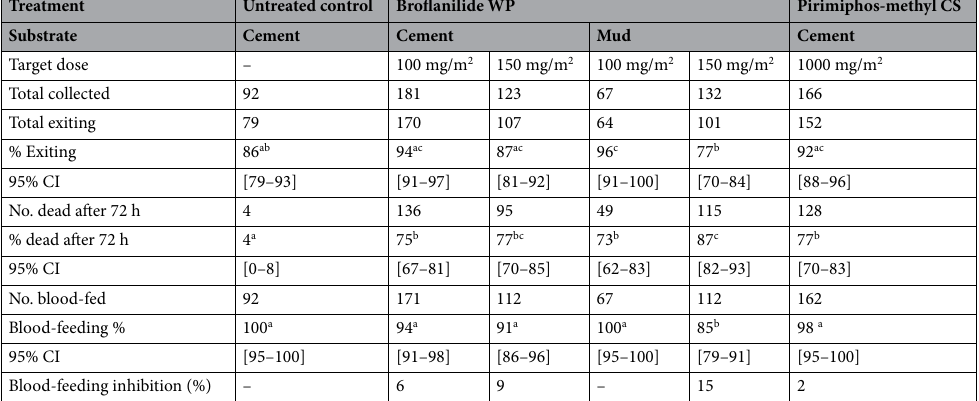
Table 3. Results with wild, free-flying pyrethroid-resistant An. ziemanni entering experimental huts in Covè, Benin. Values bearing the same letter superscript along a row are not significantly different at the 5% level (P >